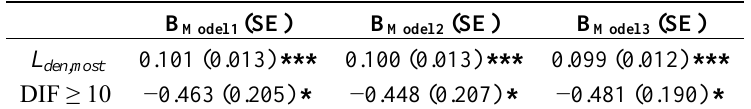
Table 2. Parameter estimates for the contribution of L (dB, continuous) and the den,most difference between L and L (DIF ≥ 10 dB versus DIF < 10) in the linear den,most den,least regression model for annoyance